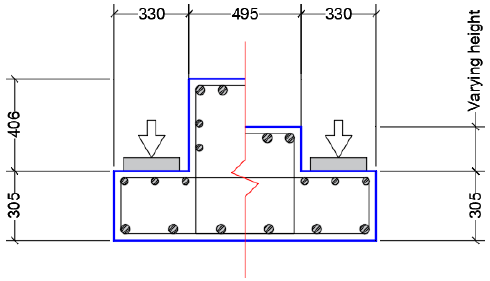
Figure 10. Beam varying web height (in mm).